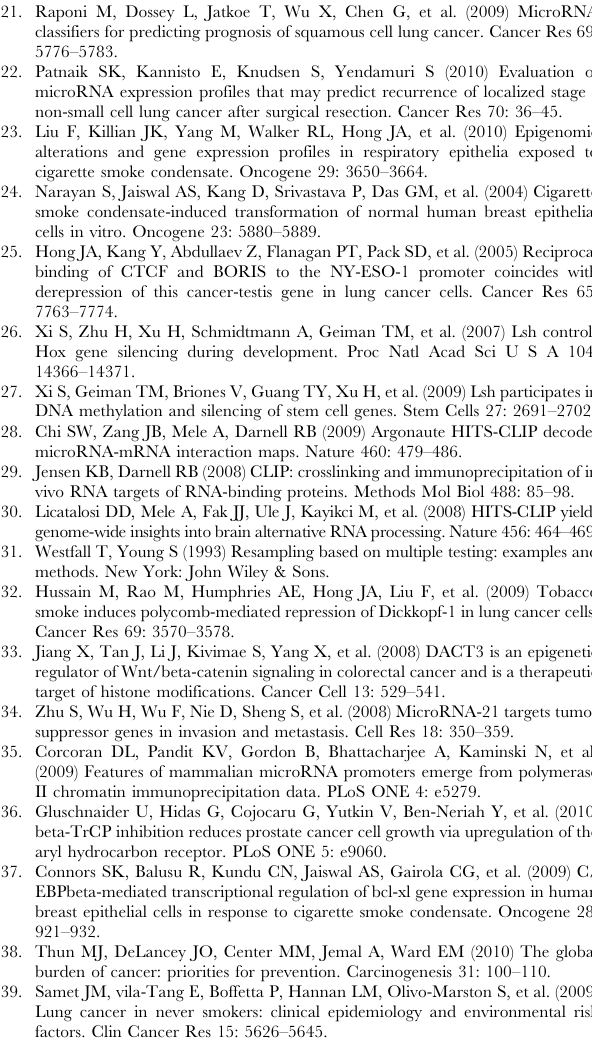
Table S1 Primer sequences for amplification, qRT-PCR, ChIP, CLIP, and site-directed